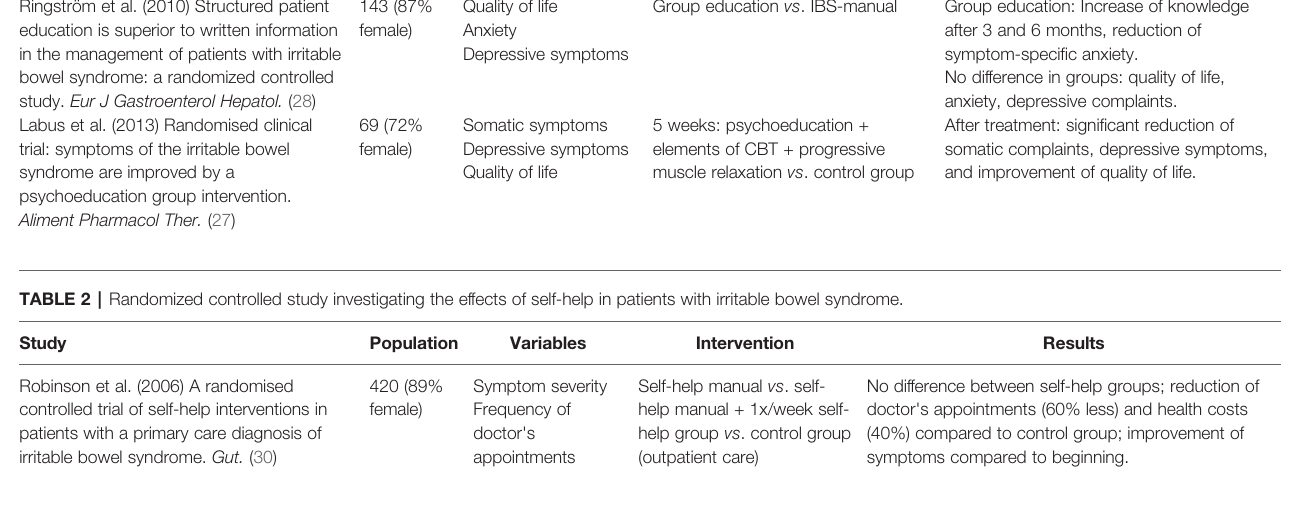
study. Eur J Gastroenterol Hepatol.